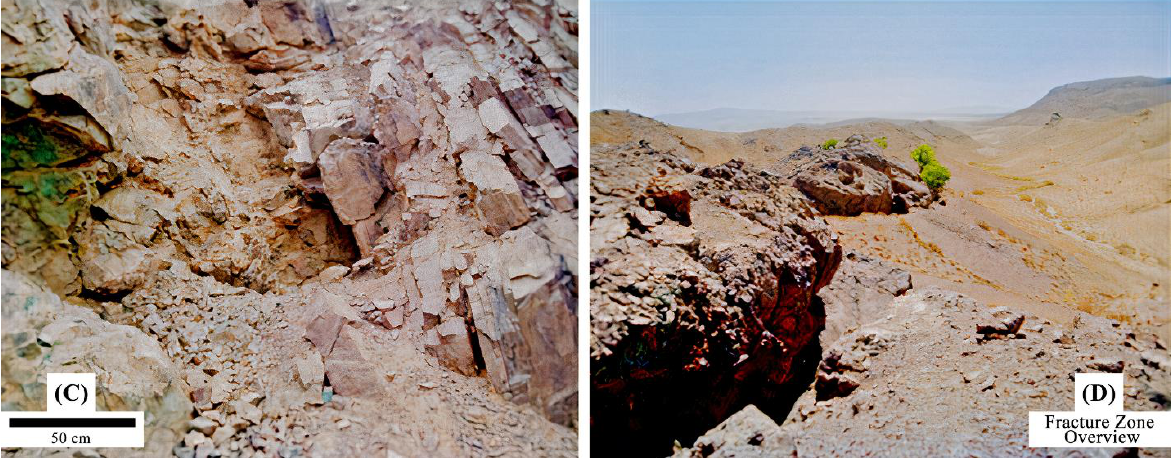
Figure 10. View of copper mineralization (malachite-azurite) points in fracture zone and andesitic- basaltic bedrock. ( A – C ) Malachite-azurite mineralization in field survey (high-intensity LF); ( D ) an overview of fracture zone in field check points.